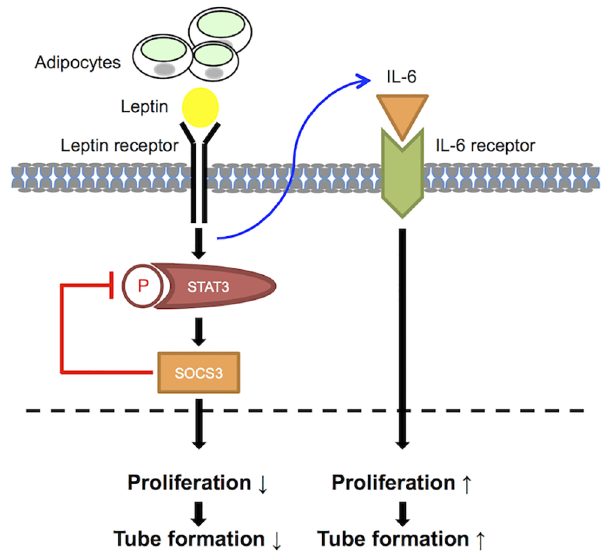
Fig 7. A model for how leptin and IL-6 regulate tube formation and cell proliferation in human lymphatic endothelial cells. Leptin derived from adipocytes regulates tube formation through controlling proliferation of HDLECs. Although leptin activates the STAT3 signaling pathway, which is downstream signaling of Ob-R, at an early time point, STAT3 phosphorylation is not increased at a late time point when SOCS3 proteins are increased by leptin. As a result, proliferation of HDLECs is decreased, leading to inhibition of tube formation. Additionally, SOCS3 induced by leptin is under the regulation of STAT3. Leptin also enhanced expression of the proinflammatory cytokine IL-6 in HDLECs. IL-6 rescues the compromised proliferation and tube formation caused by leptin in an autocrine or paracrine